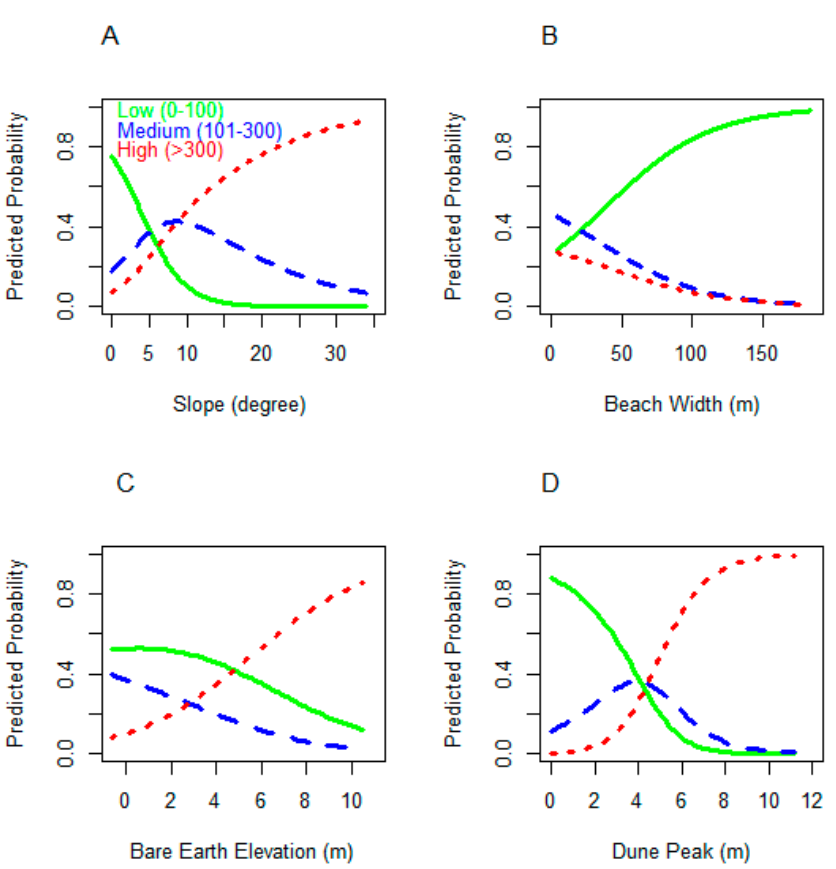
Figure 2. Predicted probability of C. caretta nest density based on: ( A ) beach slope; ( B ) beach width parameter; ( C ) bare earth elevation; and ( D ) dune peak parameter. Predicted probabilities determined through multinomial logistic regression run on individual parameters.